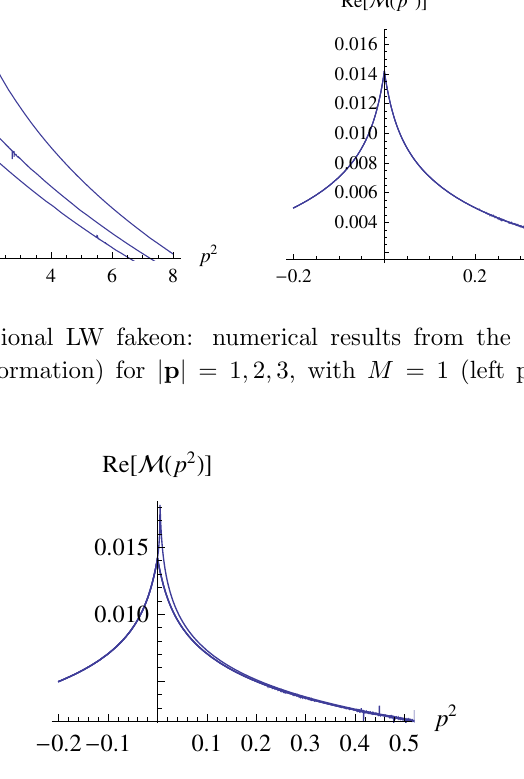
Figure 21 . Comparison between the numerical results from the nonanalytic Wick rotation (with no domain deformation) and the result of the average continuation for M = 1 =